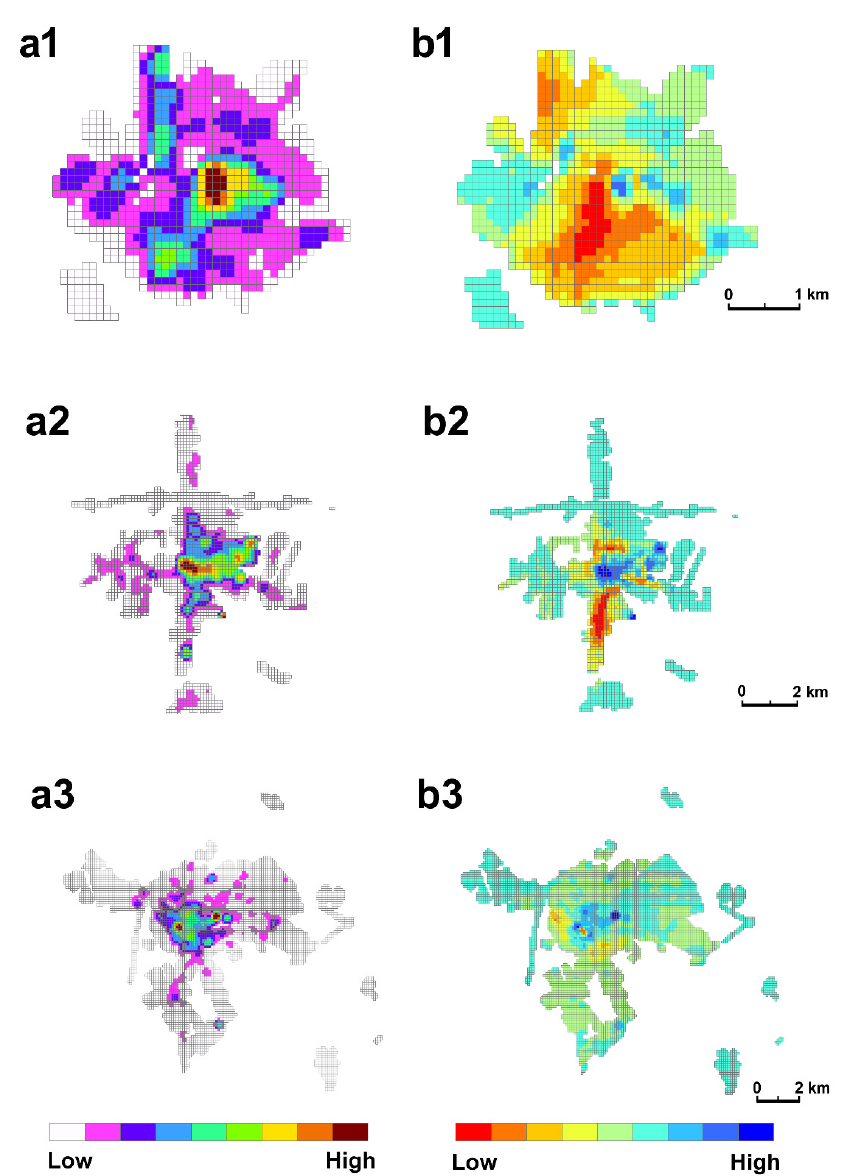
Figure 5. Crime density versus unsafety patterns: ( a ) spatial distribution of kernel density estimation (KDE) crime events ( b ); local number of KDE crime events minus local markings of unsafety, where low values indicate more unsafety markings than KDE crime events and high values indicate more KDE crime events than unsafety markings (in some selected cities): ( 1 ) Balmazújváros; ( 2 ) Nagykanizsa; ( 3 ) Székesfehérvár.